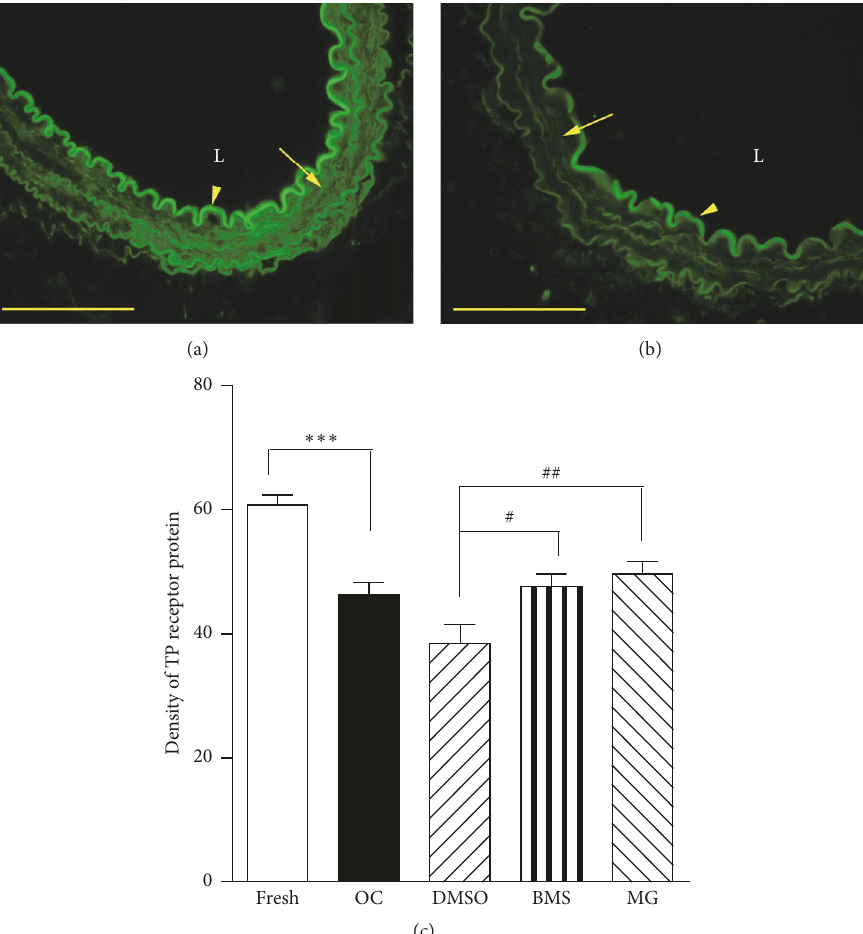
Figure 4: TP receptor protein expression in the fresh segments (a) and following organ culture for 24 h (b). The arteries were denuded of endothelium; the innermost autofluorescent inner elastic membrane is easily depicted (arrow head). The smooth muscle cell protein expression is homogenously distributed (arrow). L indicates lumen. The scale bar = 100 𝜇 m. The protein expression was quantified using the program Image J software (c). Each data point is derived from 6 experiments. Unpaired Student’s 𝑡 -test was used. ∗∗∗ 𝑃 < 0.001 versus fresh; # 𝑃 < 0.05 , ## 𝑃 < 0.01 versus